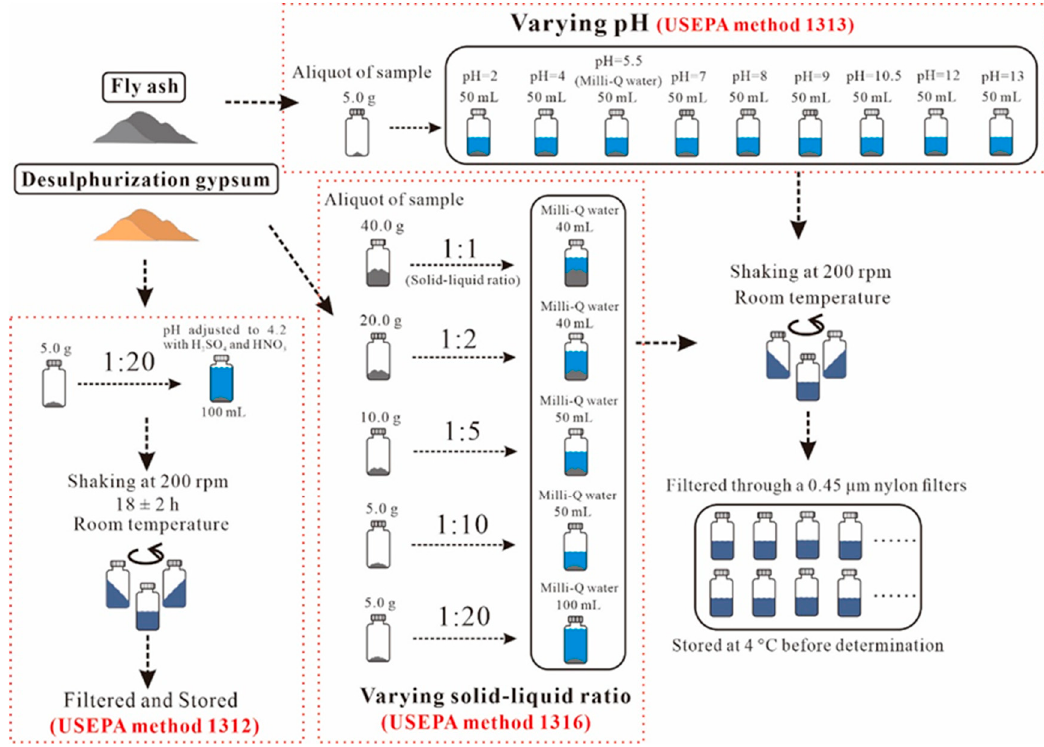
Figure 1. Leaching experiment process following USEPA methods 1312, 1313, and 1316.